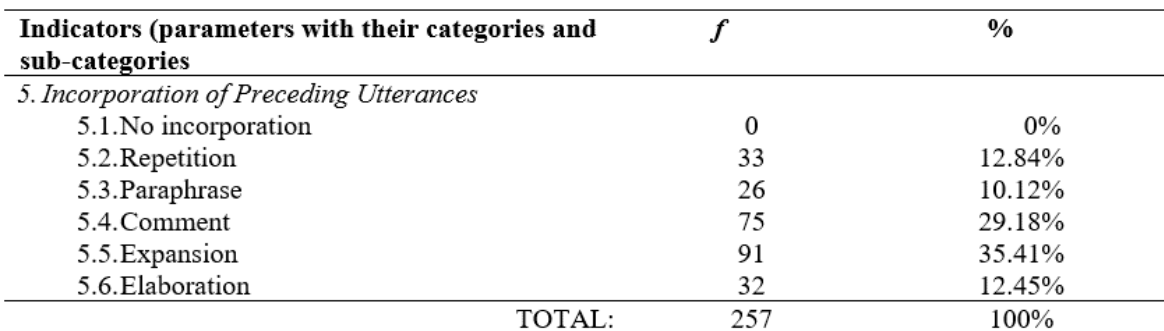
Table 6. Incorporation of Preceding Utterances as a Communicative Feature in English Language